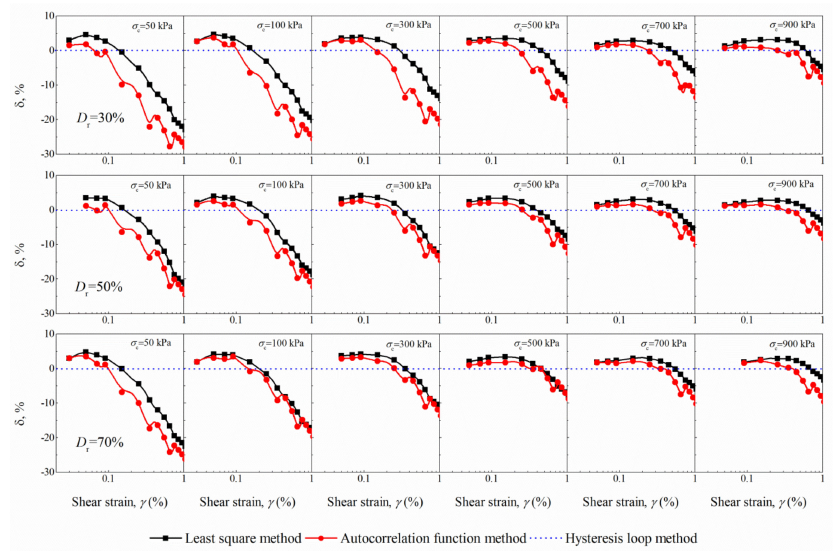
Figure 8. Percentage changes in G for two determination methods ( D r = 30, 50, 70% and σ c = 50~900